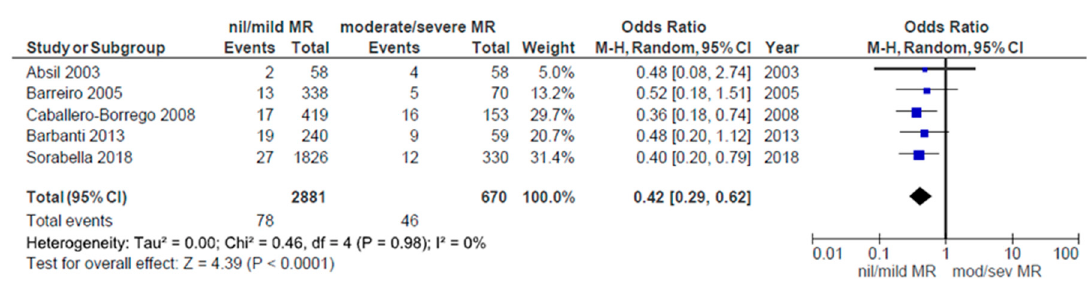
Figure 8. Comparative 30-day mortality: nil / mild vs. moderate / severe MR groups.